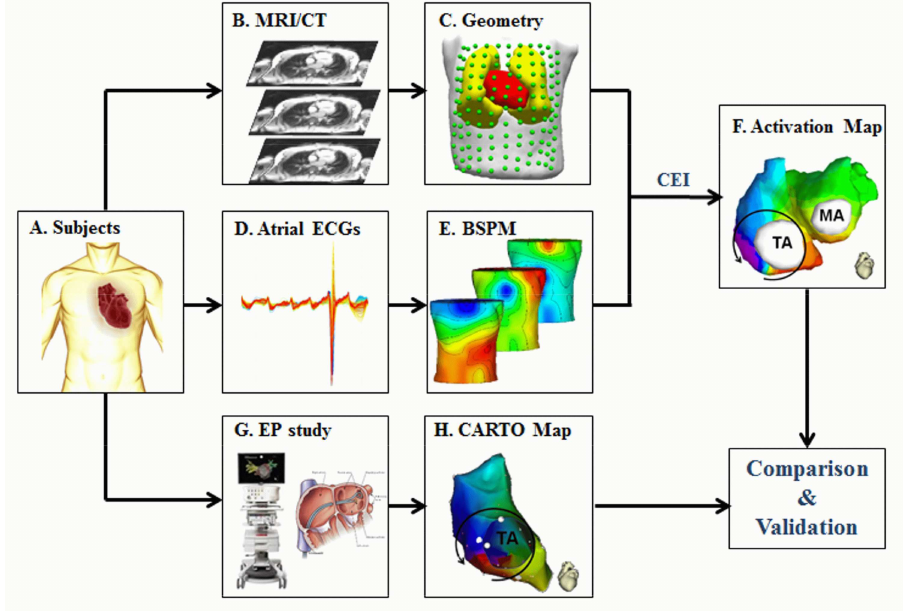
Fig 1. Schematic diagram of the present study. BSPM = Body surface potential